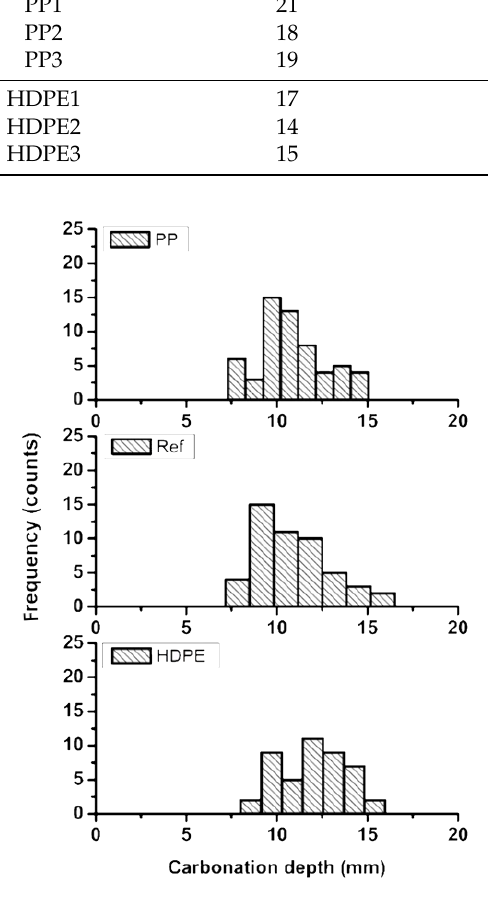
Buildings 2022 , 12 , x FOR PEER REVIEW Figure 5. Histogram of the carbonation measurement results. Figure 5. Histogram of the carbonation measurement results.